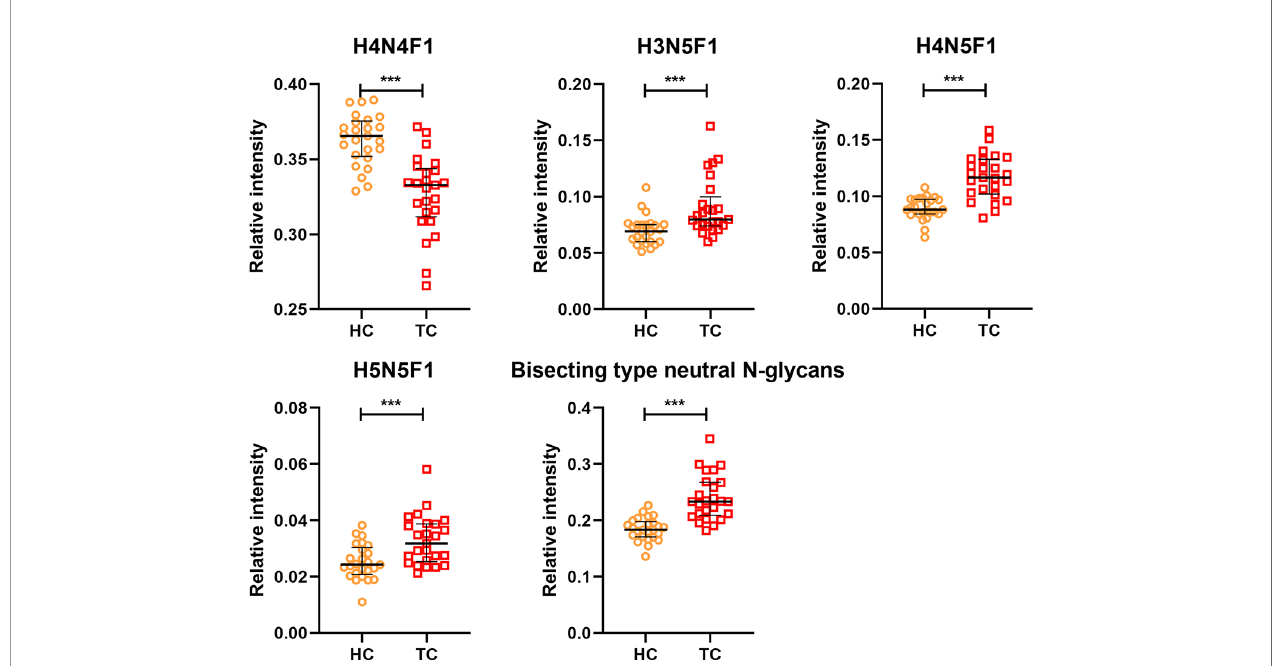
FIGURE 2 | The scatter plots of main directly detected and derived glycan traits in thyroid cancer (TC) and healthy controls (HC) for the discovery cohort. The whiskers represent “ median with IQR ” . ***p-value < 0.001 (after Bonferroni correction).